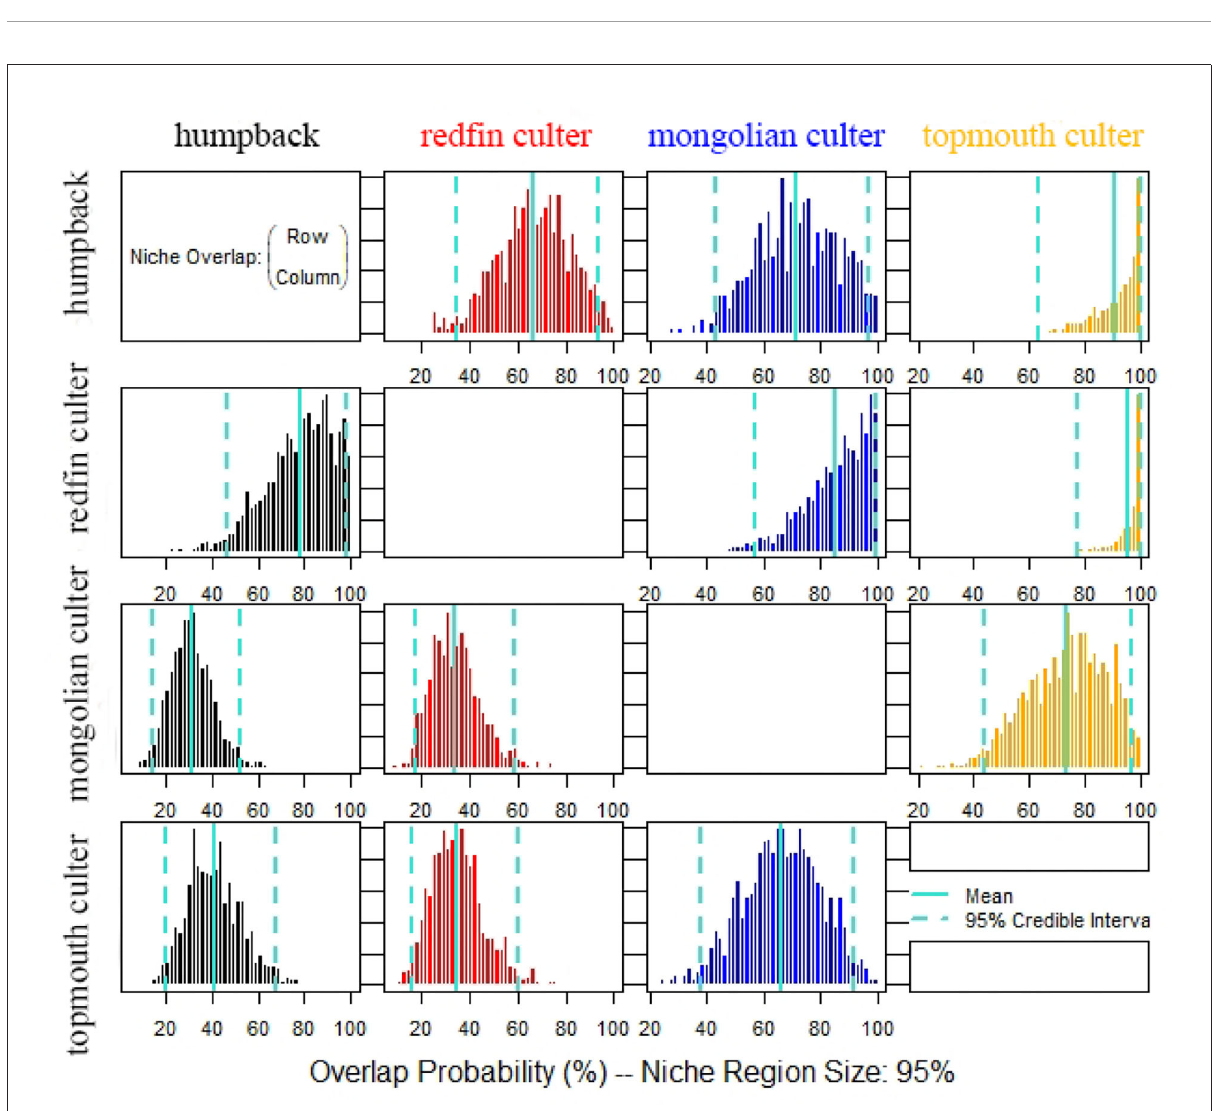
FIGURE4 Posterior distribution of the probabilistic niche overlap metric (%) and niche region size ( α ) = 0.95, indicating the probability of one species (row) overlapping onto the niche of another species (column) among topmouth culter, Mongolian culter, humpback, and redfin culter in Lihu